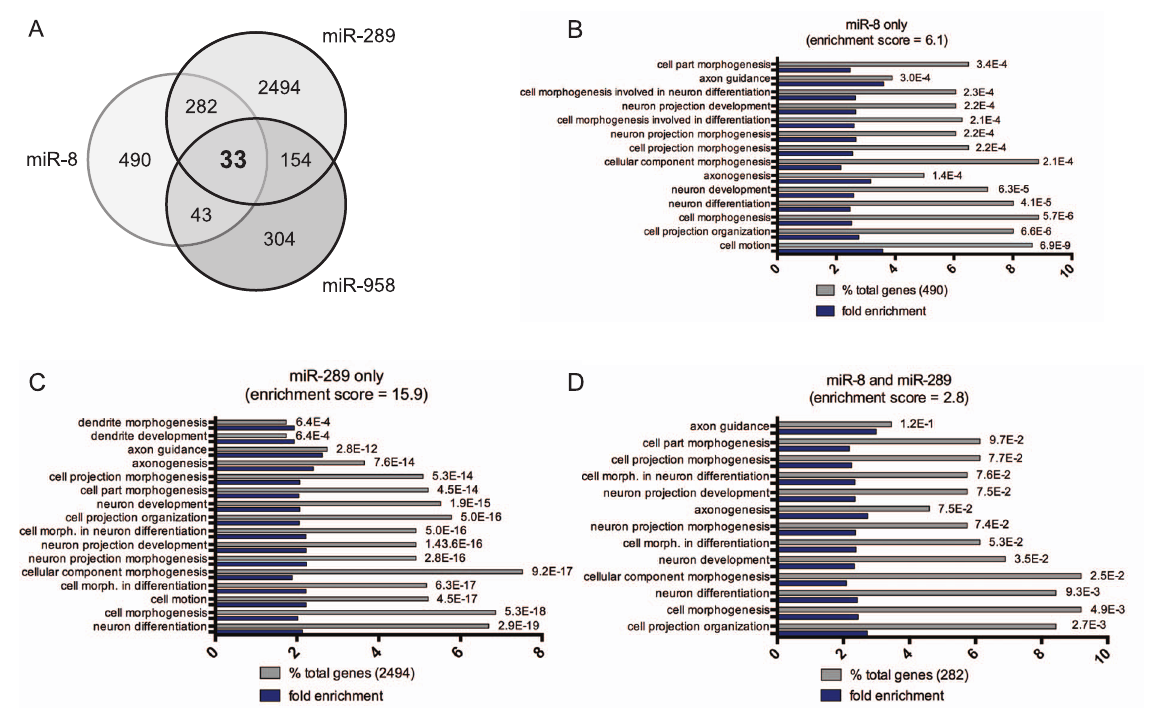
Figure 5. Predicted targets of miRs-8 and -289 are found in neuron-related enriched functional annotation clusters. (A) Venn diagram showing predicted mRNA targets for activity-regulated miRNAs. Notably, 33 mRNAs have putative binding sites for miRs-8, -289, and -958. 282 mRNAs have putative binding sites for miRs-8 and -289. (B-C) Functional annotation cluster analysis for predicted targets of miRs-8, -289 and both miRs-8 and -289. Only clusters enriched with targets significantly enriched in clusters involved in the control of neuronal processes are shown here. Note that the 304 predicted targets for miR-958 were not enriched in these clusters. Enrichment scores for each cluster are indicated [29,30]. Genes within each category are indicated as a percentage of total genes (gray bar) and fold enrichment (blue bar) over expected number of genes in that category in the Drosophila genome. Statistical significance (Benjamini corrected p-values) for each category is indicated to right of gray columns.